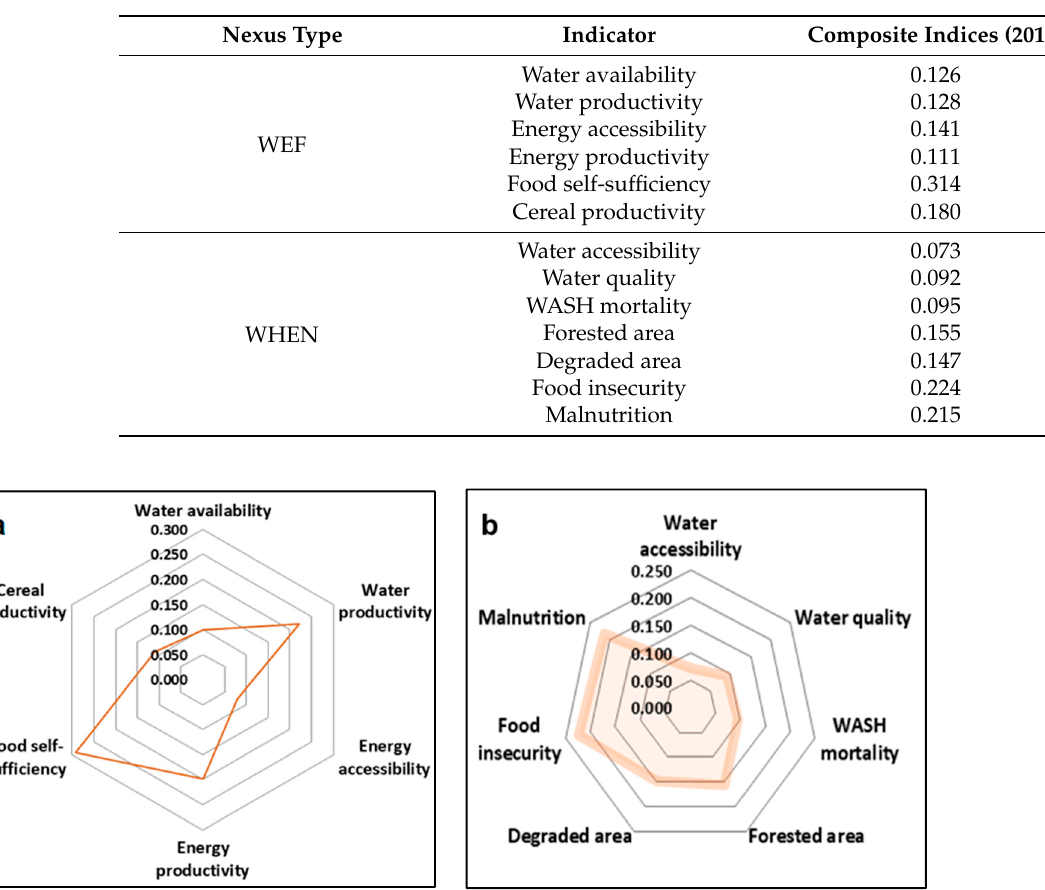
Table 3. WEF nexus composite indices for South Africa for the year 2015.